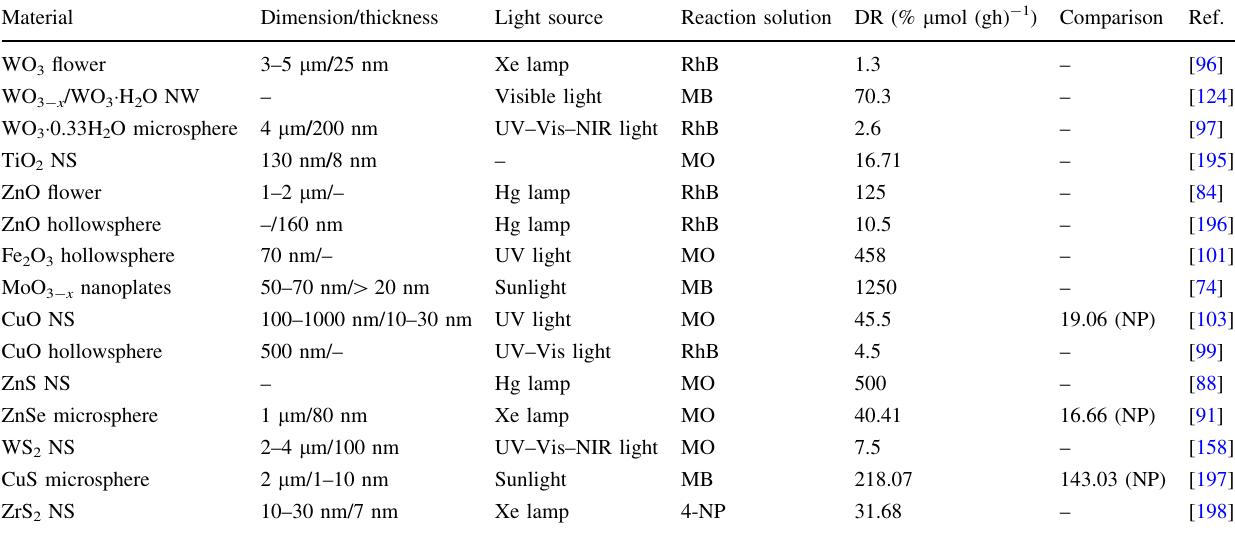
Table 4 Summary of pollutant degradation performances of 2D bare TMO&Cs Material